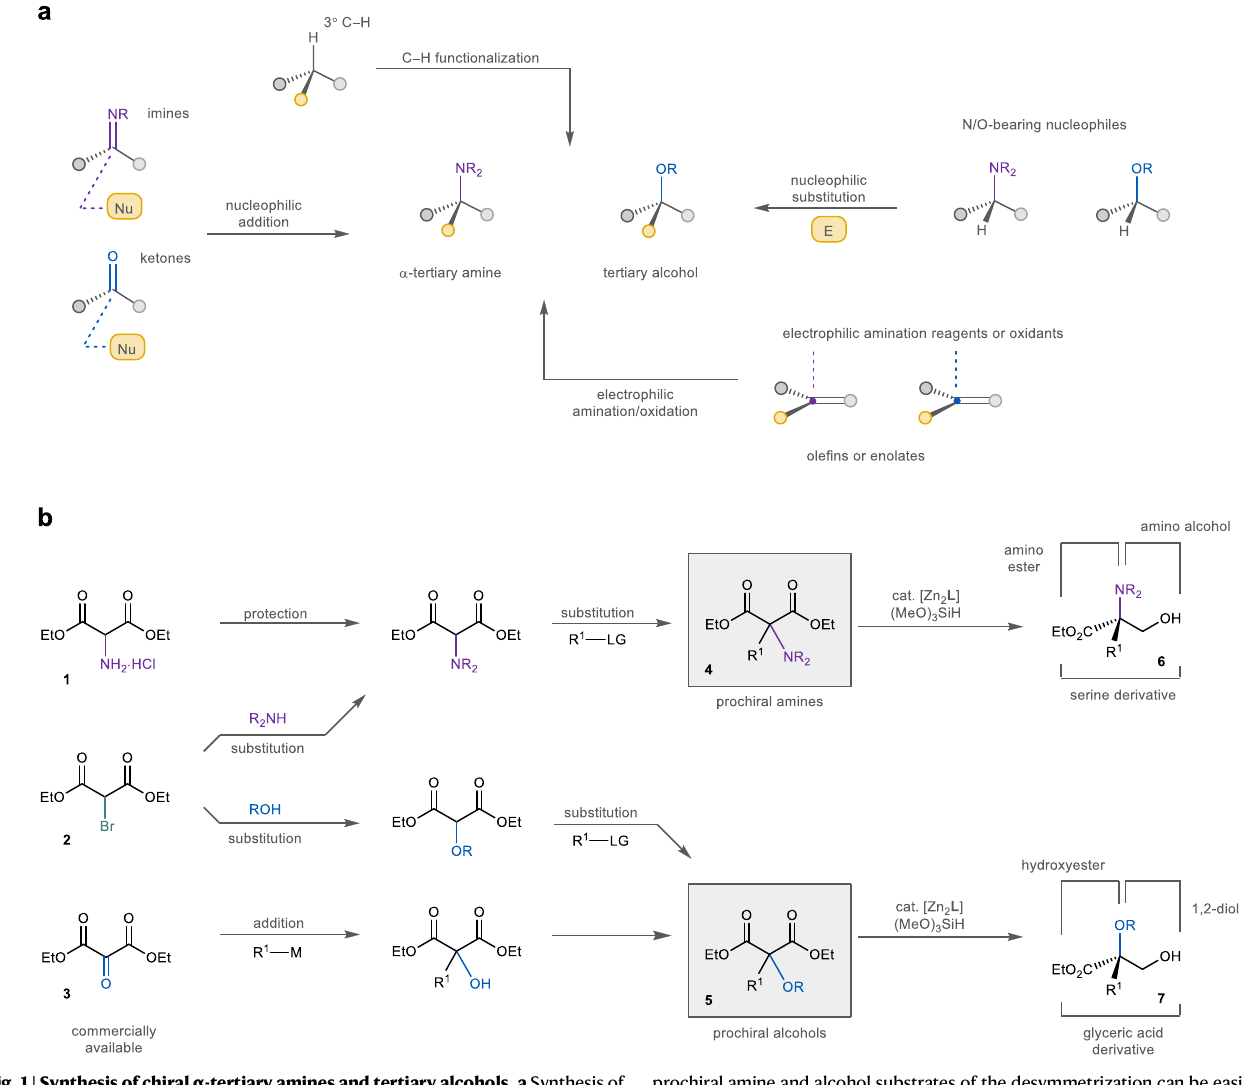
Fig.1|Synthesisofchiral α -tertiaryaminesandtertiaryalcohols.a Synthesisof chiral α -tertiary amines and tertiary alcohols. Nu nucleophile, E electrophile. b Reductive desymmetrization of amino- and oxymalonic esters (this work).